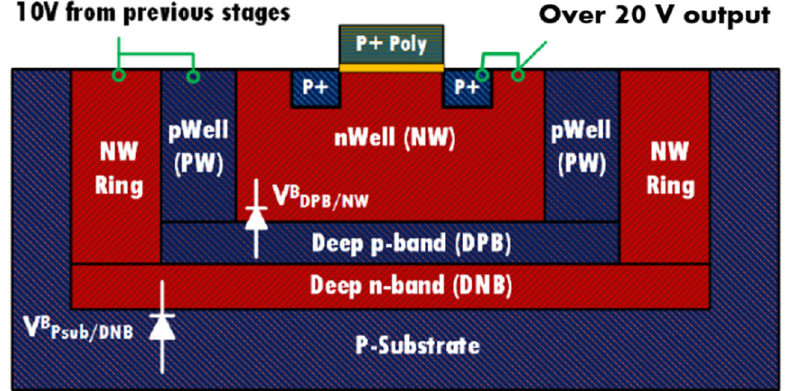
Figure 7. Triple-well isolation.